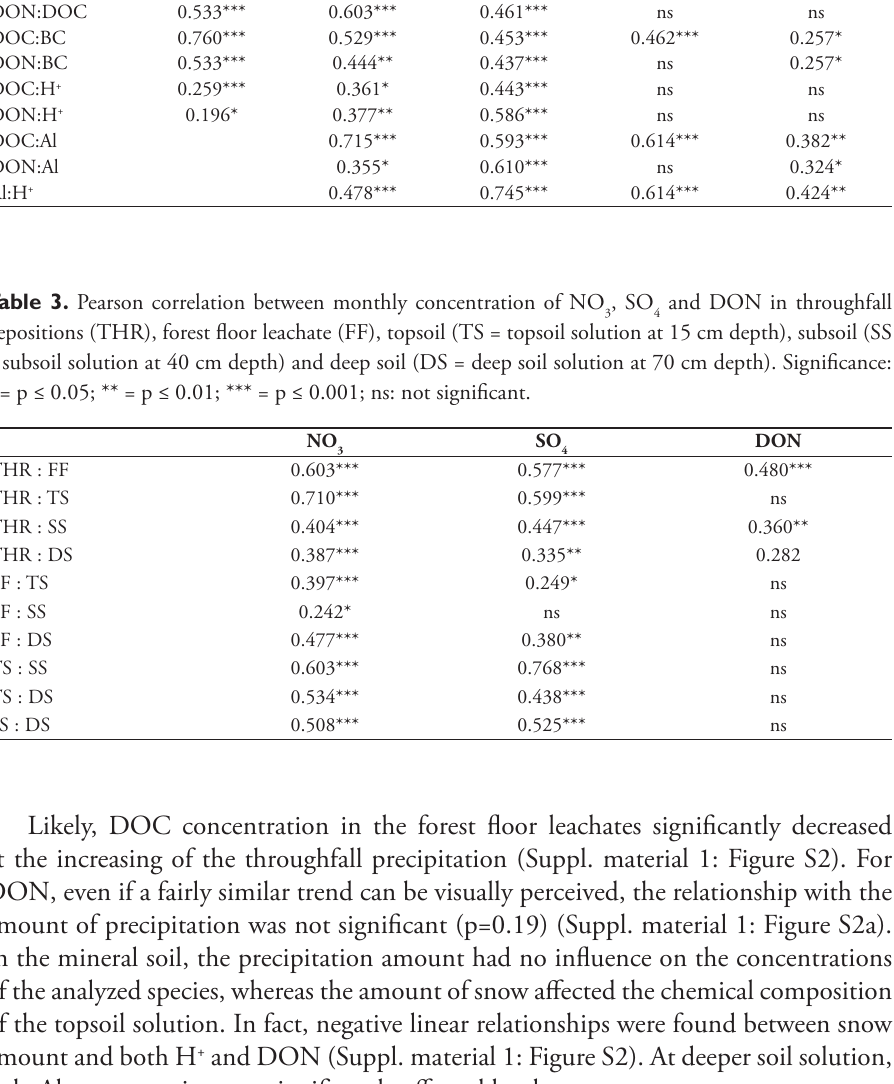
Table 2. Pearson correlation between monthly average concentration of throughfall depositions (THR), forest floor leachate (FF), topsoil (TS = topsoil solution at 15 cm depth), subsoil (SS = subsoil solution at 40 cm depth) and deep soil (DS = deep soil solution at 70 cm depth). Significance: * = p ≤ 0.05; ** =p ≤